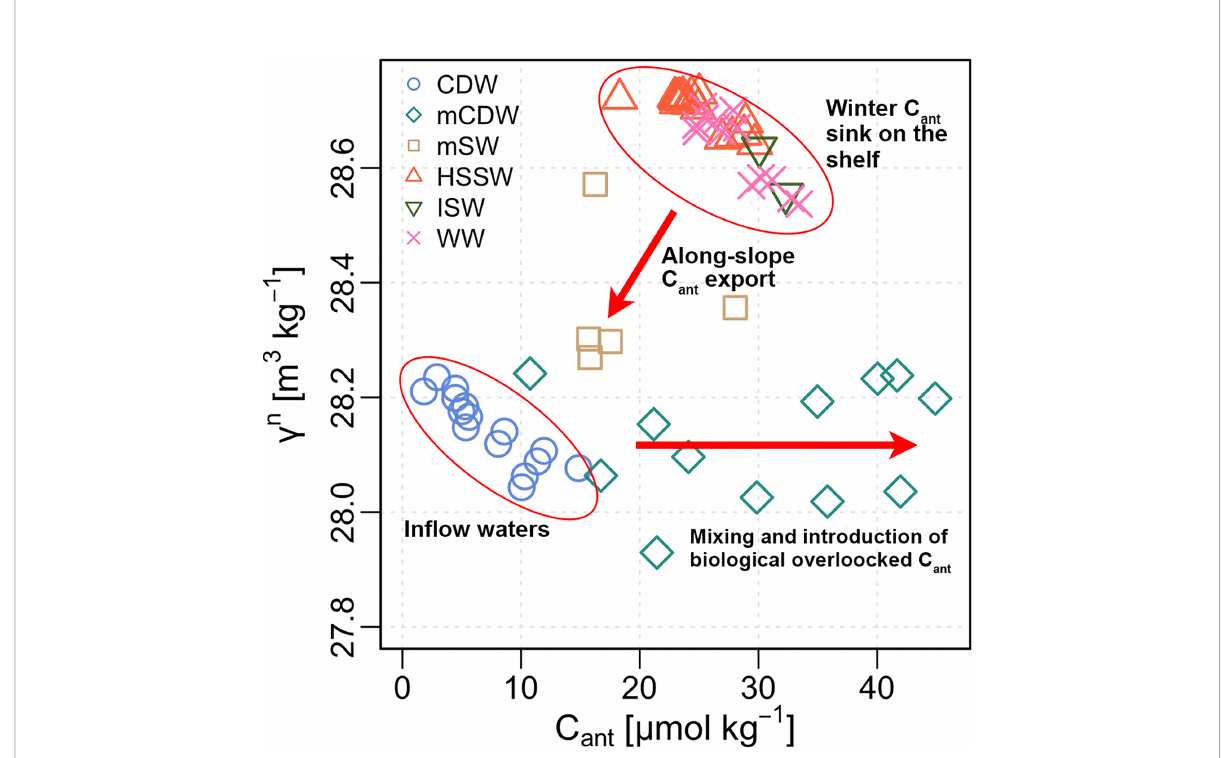
FIGURE 8 Neutral density anomaly ( g n ; kg, m − 3 ) vs. C ant ( m mol kg − 1 ) concentrations for each identi fi ed water mass, along with oceanographic and biogeochemical processes driving the observed C ant distribution in the Ross